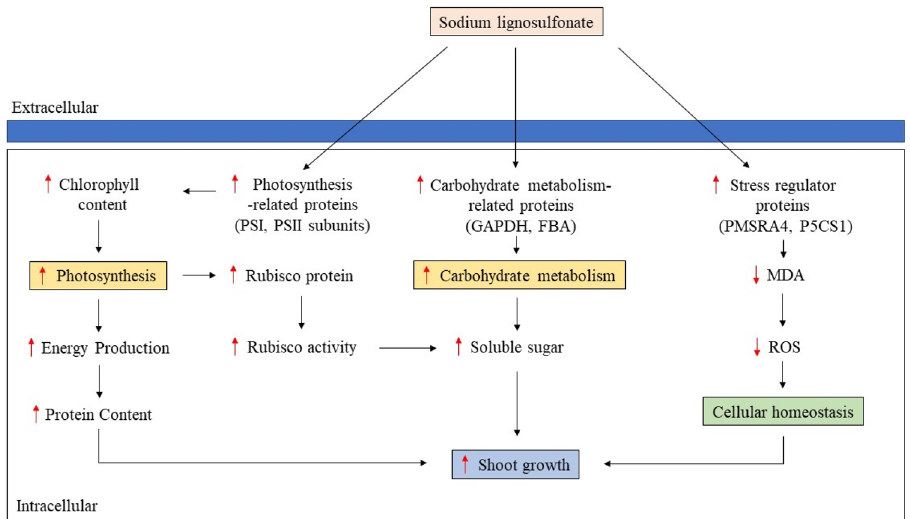
Figure 5. Proposed mode of action of NaLS on MR 219 during shoot growth. PSI photosystem I, PSII photosystem II, GAPDH glyceraldehyde-3-phosphate dehydrogenase 3, FBA fructose-bisphosphate aldolase, PMSRA4 peptide methionine sulfoxide reductase A4, P5CS1 delta-1-pyrroline-5-carboxylate synthase 1, Rubisco ribulose-1,5-bisphosphate carboxylase/oxygenase, MDA malondialdehyde, ROS reactive oxygen species, ↑ increased, ↓